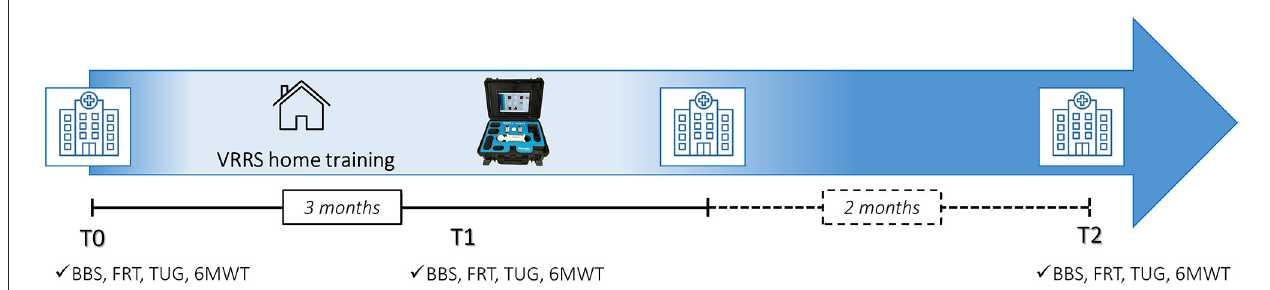
FIGURE 1 | Timeline of the study. BBS, berg balance scale; FR, functional reach test; TUG, timed up and go; 6MWT, six-minute walk test; T0, baseline; T1, in the week after the end of the training; T2, 2 months after the end of the training.